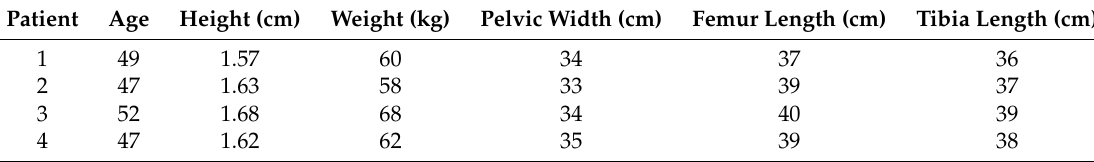
Figure 10. Simulation scheme in CODA motion software to obtain therapy reference values. Table 3. Patients’ anthropometric